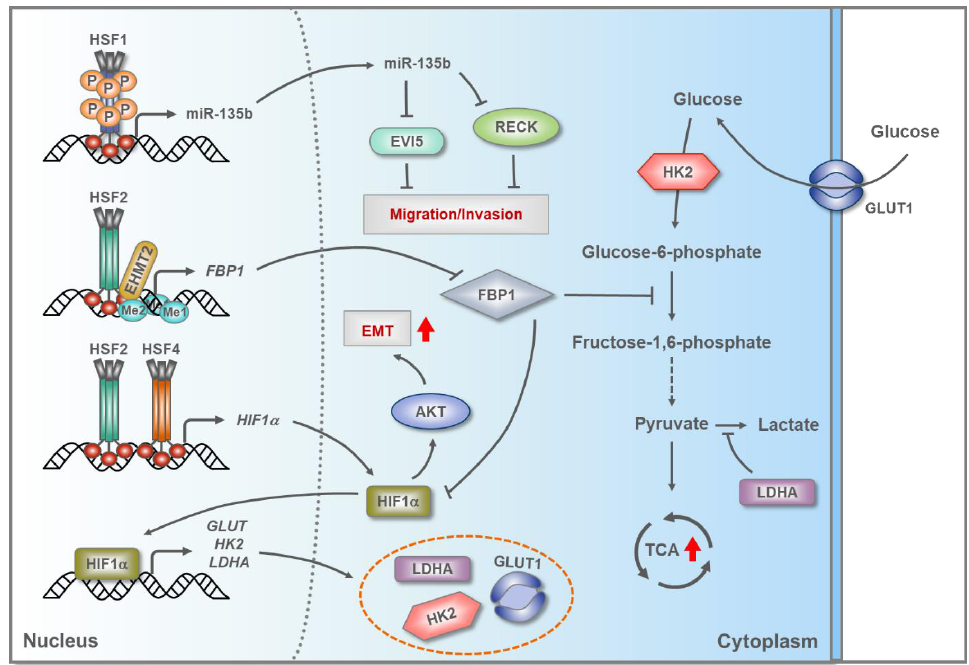
Figure 3. Hepatocellular carcinoma (HCC) cells use HSFs to promote metabolic reprograming and cancer invasion. In HCC, trimeric human HSF1, HSF2 and HSF4 bind to DNA and induce the transcription of genes that modulate multiple biological processes that support tumorigenesis. HSF1 enhances the expression of miR-135b that targets reversion-inducing cysteine-rich protein with Kazal motifs (RECK) and ecotropic viral integration site 5 protein homolog (EVI5), both of which are repressors of migration and invasion. Together, HSF2 and euchromatic histone lysine methyl transferase 2 (EHMT2) promote methylation of the gene encoding fructose-bisphosphatase 1 (FBP1), resulting in a decreased expression of FBP1, an enzyme that can counteract glycolysis and inhibit the expression of hypoxia-inducible factor 1 alpha (HIF-1α). Together with HSF4, HSF2 modulates the expression of HIF-1α, which regulates a myriad of genes, including glucose transporter GLUT1, hexokinase-2 (HK2), and L -lactate dehydrogenase A (LDHA), all of which are involved in various